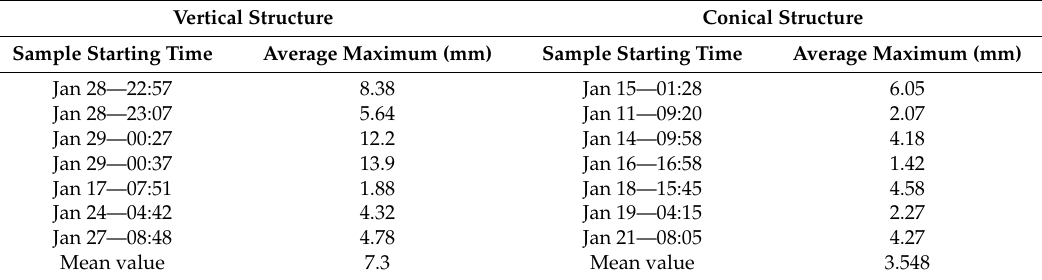
Table 2. Average maximum amplitudes